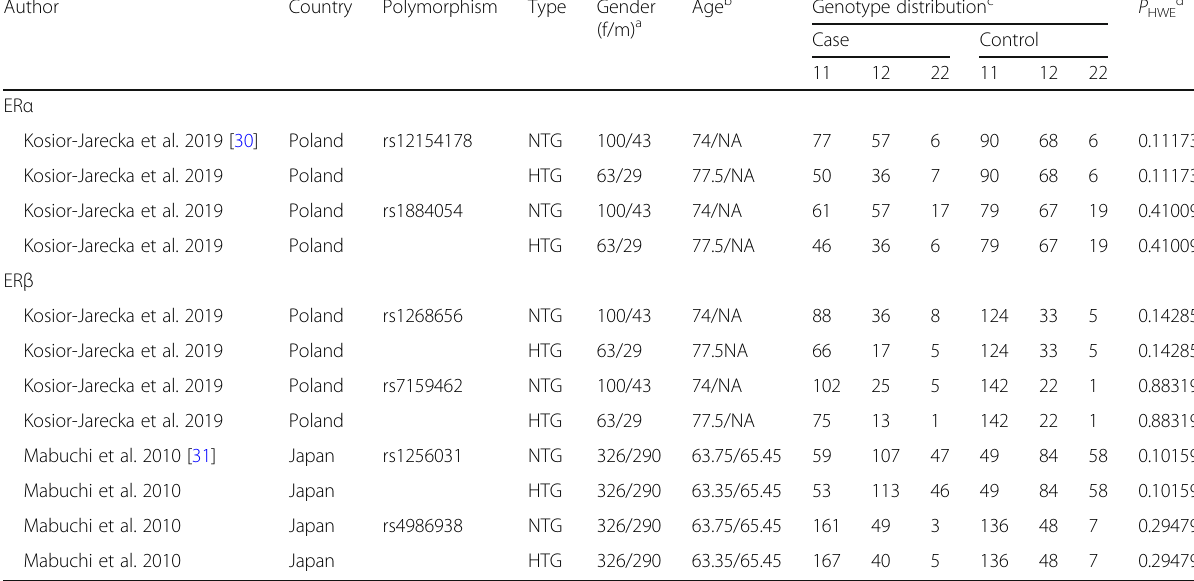
Table 2 Characteristics of individual studies for the associations between ER polymorphisms and the risk of